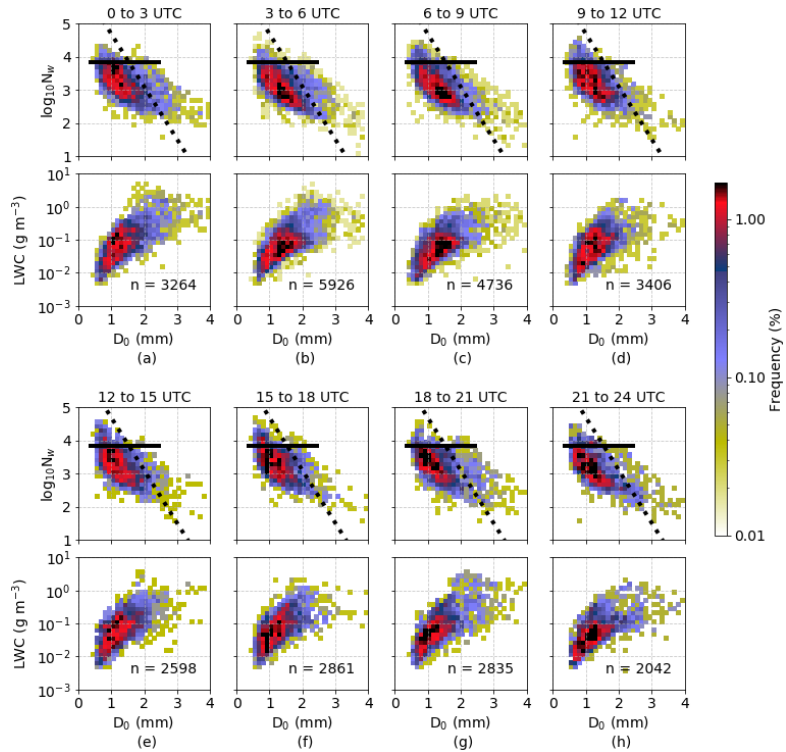
Figure 7. Histograms of log N w - D 0 and LWC- D 0 for Region A every 3-hour interval: ( a ) 0000 to 0300 UTC, ( b ) 0300 to 0600 UTC, ( c ) 0600 to 0900 UTC, ( d ) 0900 to 1200 UTC, ( e ) 1200 to 1500 UTC, ( f ) 1500 to 1800 UTC, ( g ) 1800 to 2100 UTC, and ( h ) 2100 to 2400 UTC. The solid and dotted lines in the log N w - D 0 histograms indicate the C/S separations by TH15 and BR09,